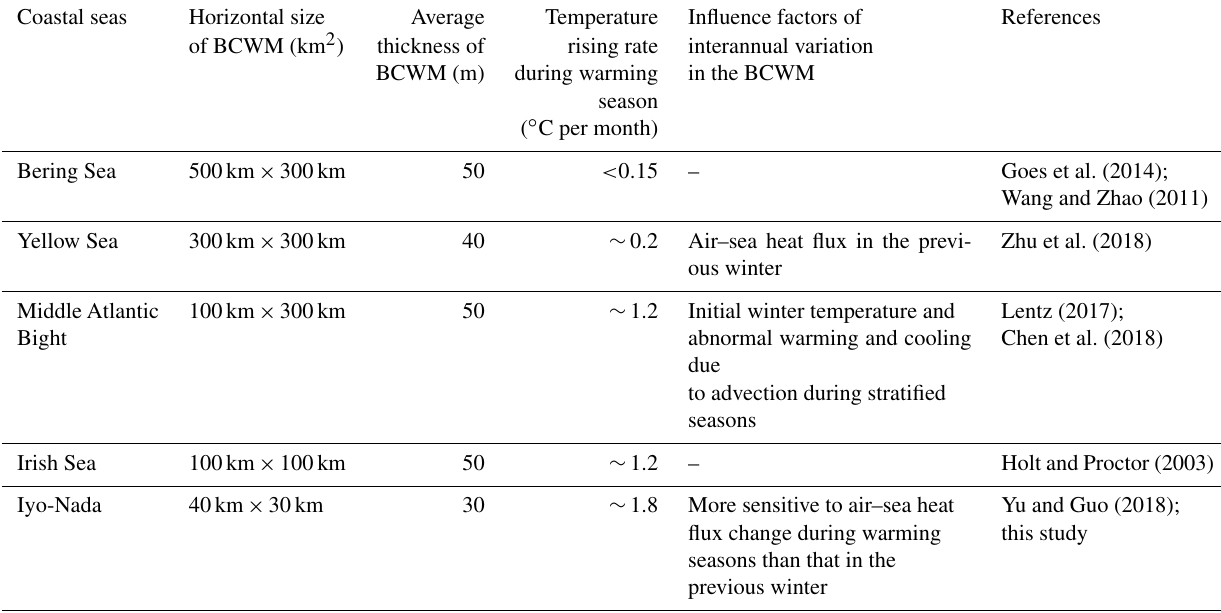
Table 3. Characteristics of bottom cold water mass (BCWMs) in five coastal seas. Coastal seas Horizontal size Average Temperature of BCWM (km 2 ) thickness of rising rate interannual variation BCWM (m) during warming in the BCWM season ( ◦ C per month) Bering Sea 500km × 300km 50 < 0 . 15 – Goes et al. (2014); Wang and Zhao (2011) Yellow Sea 300km × 300km 40 ∼ 0.2 Zhu et al. (2018) ous winter Lentz (2017); Middle Atlantic 100km × 300km Chen et al. (2018) Bight to advection during stratified Irish Sea 100km × 100km